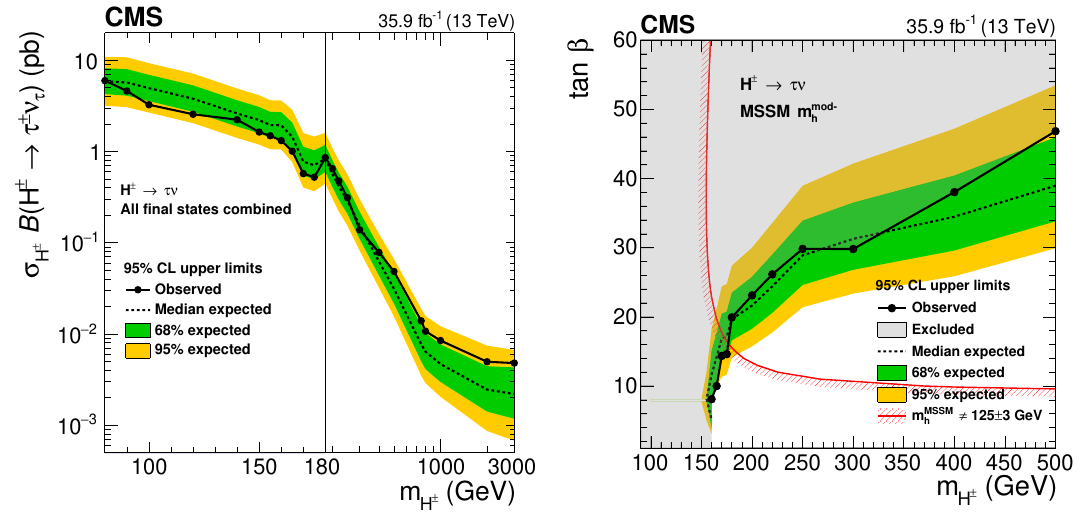
Figure 6 . The observed 95% CL exclusion limits on σ pared to the expected limit assuming only standard model processes (dashed line) for the H ± mass range from 80 GeV to 3 TeV (left), and the same limit interpreted in the m mod- h benchmark scenario (right). The green (yellow) bands represent one (two) standard deviations from the expected limit. On the left, the horizontal axis is linear from 80 to 180 GeV and logarithmic for larger m On the right, the region below the red line is excluded assuming that the observed neutral Higgs boson is the light CP-even 2HDM Higgs boson with a mass of 125 is the theoretical uncertainty in the mass